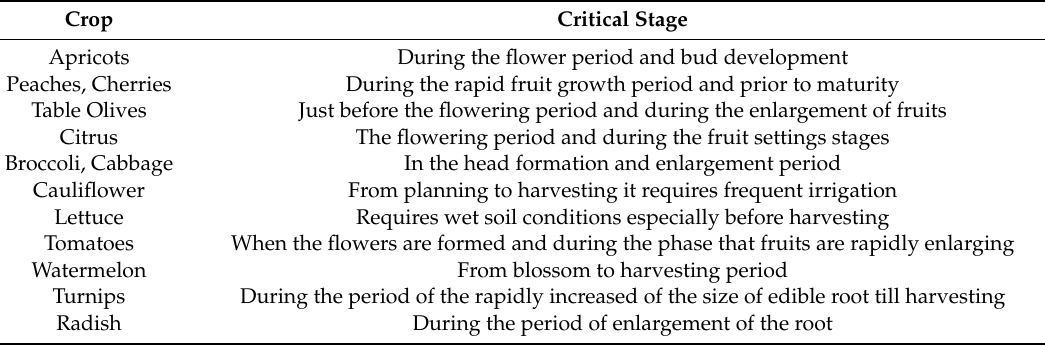
Table 3. Critical stages for several crops. Data adapted from